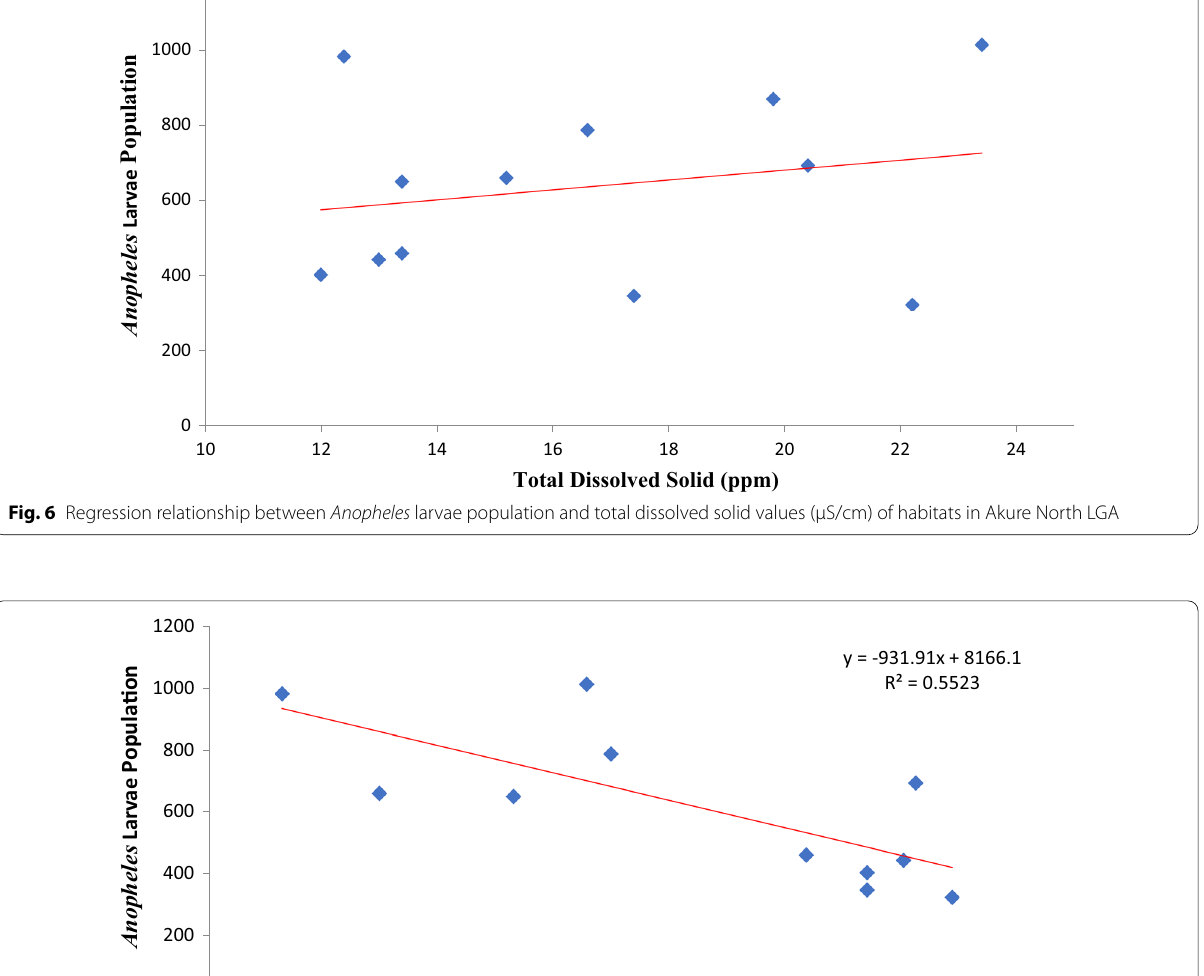
Fig. 7 Regression relationship between Anopheles larvae population and dissolved oxygen values (µS/cm) of habitats in Akure North